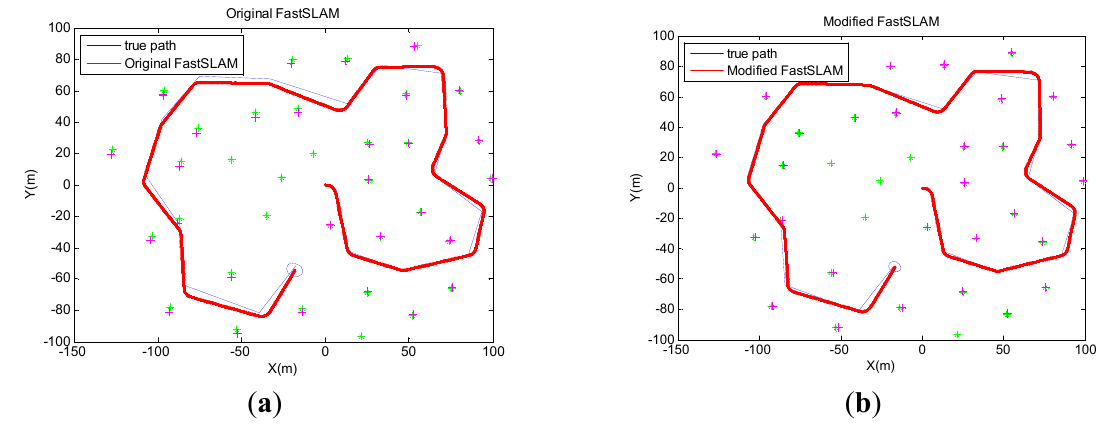
Figure 4. Results of FastSLAM and modified-FastSLAM obtained by averaging over 50 Monte-Carlo